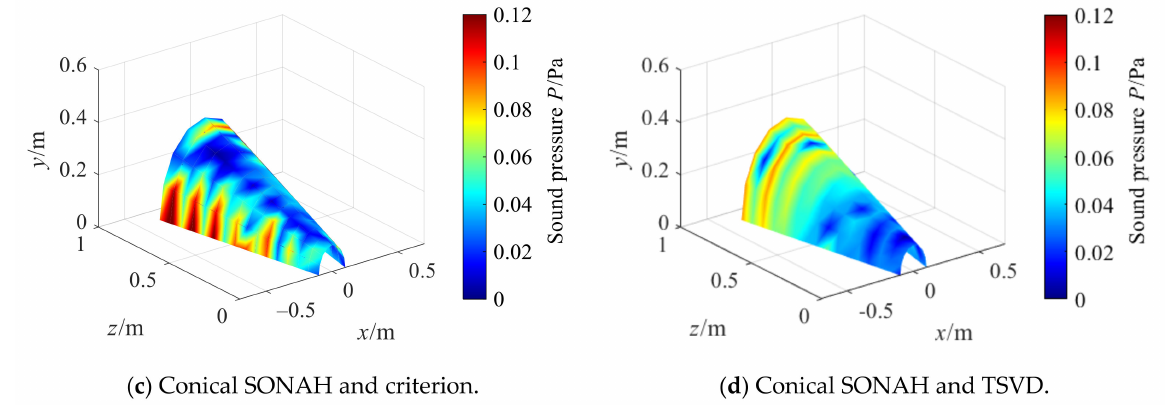
Figure 25. Reconstruction by conical SONAH.